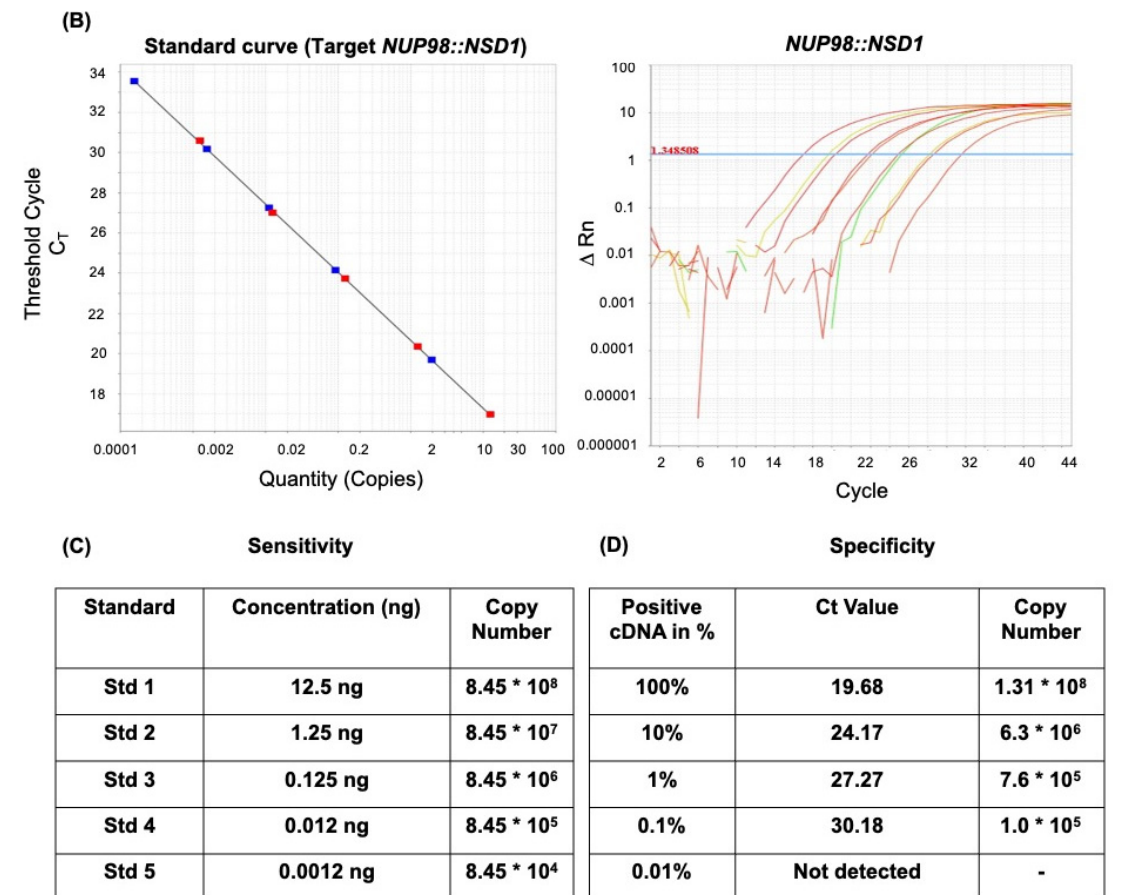
Figure 1. ( A ) Schematic representation of molecular cloning and validation strategy for NUP98::NSD1 DNA sequence in expression vector pcDNA/TO5 plasmid vector. The plasmid with the NUP98::NSD1 gene was used as a positive control/standard for developing the quantitative assay. ( B ) Development of the NUP98::NSD1 screening assay. This figure shows the standard curve plot obtained with a slope of − 3.389 with an R 2 (correlation coefficient) of 1. The variation of the Ct between the replicates was found to be <0.5 Ct, and the standard deviation was <0.15. The table represents the known concentration of standards with their corresponding copy number detected using qRT-PCR. ( C ) The sensitivity of the assay was determined by serially diluting the NUP98::NSD1 plasmid. ( D ) The assay’s specificity was determined by serially diluting the NUP98::NSD1 positive patient sample with healthy donor cDNA, as described in the